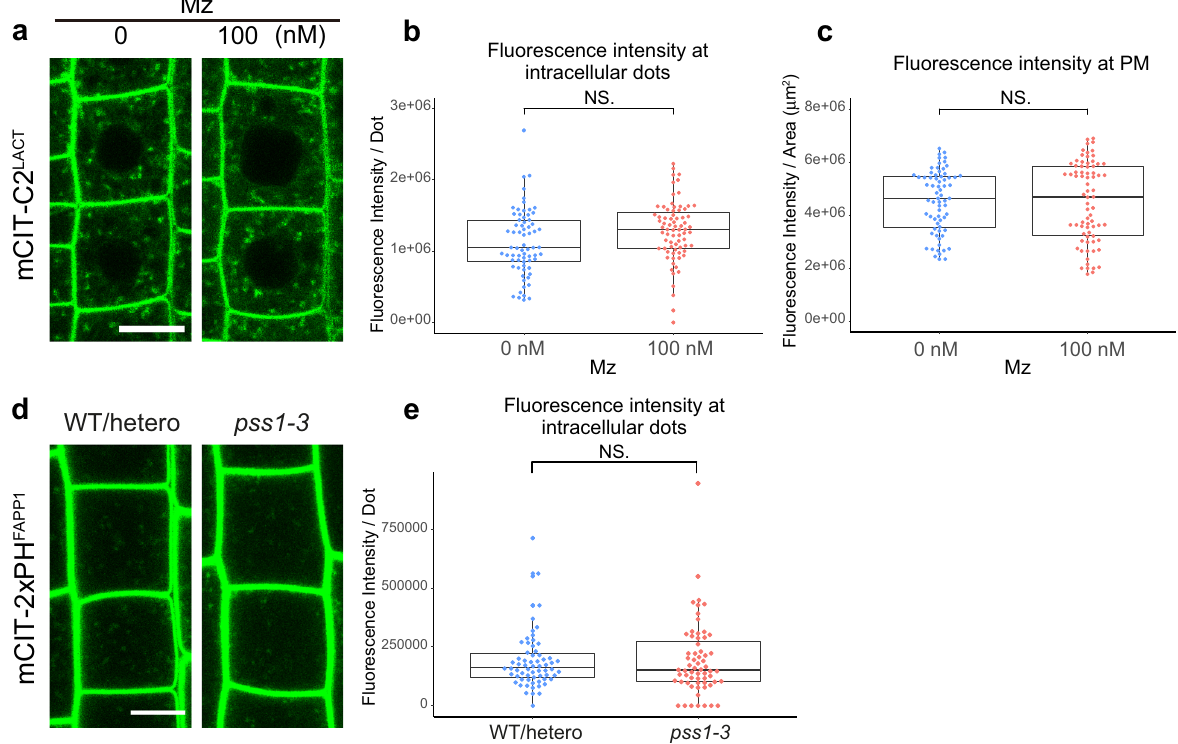
Fig. 5 PS does not impact PI4P distribution at TGN. a Confocal micrographs of Arabidopsis root epidermal cells expressing the PS biosensor mCIT-C2 LACT upon 0 or 100 nM metazachlor (Mz) treatment. Fluorescence intensity at intracellular dots ( b ) and at PM ( c ) was quanti fi ed. The distribution of the PS biosensor was not altered upon Mz treatment ( a – c ). n = 69 cells from 23 roots (0 nM), 75 cells from 25 roots (100 nM). d Confocal micrographs of Arabidopsis root epidermal cells expressing the PI4P biosensor mCIT-2×PH FAPP1 in wild-type/heterozygote plants or pss1-3 homozygote mutant. e Fluorescence intensity at intracellular dots was quanti fi ed. PI4P quantity at intracellular dots was not modi fi ed in pss1-3 mutant. n = 66 cells from 22 roots (WT/hetero), 63 cells from 21 roots ( pss1-3 ). Statistics were done by two-sided Wilcoxson ’ s rank-sum test. Each element of the boxplot indicates the following value: center line, median; box limits, the fi rst and third quartiles; whiskers, 1.5× interquartile range; points above or below the whiskers, outliers. Scale bars, 10 µ